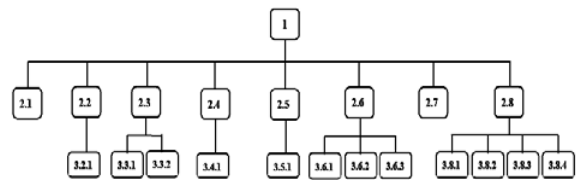
Fig.4. The graphical model-tree illu strating the social significance of the biosystems [5]. Where: 1. Biosystems,